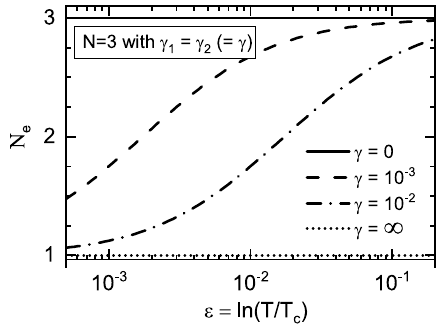
Fig. 7 Fluctuation specific heat c fl from our expressions for three-layer superconductors with a single Josephson coupling, 𝛾 = 𝛾 1 = 𝛾 2 , as a function of the reduced temperature 𝜀 and for dif- ferent 𝛾 . The c fl is given in arbitrary units (and is proportional to the also observables − 𝜒 fl ∕ T and 𝜎 flAL ). See also Figs. 8 and 9 for an interpretation of the results